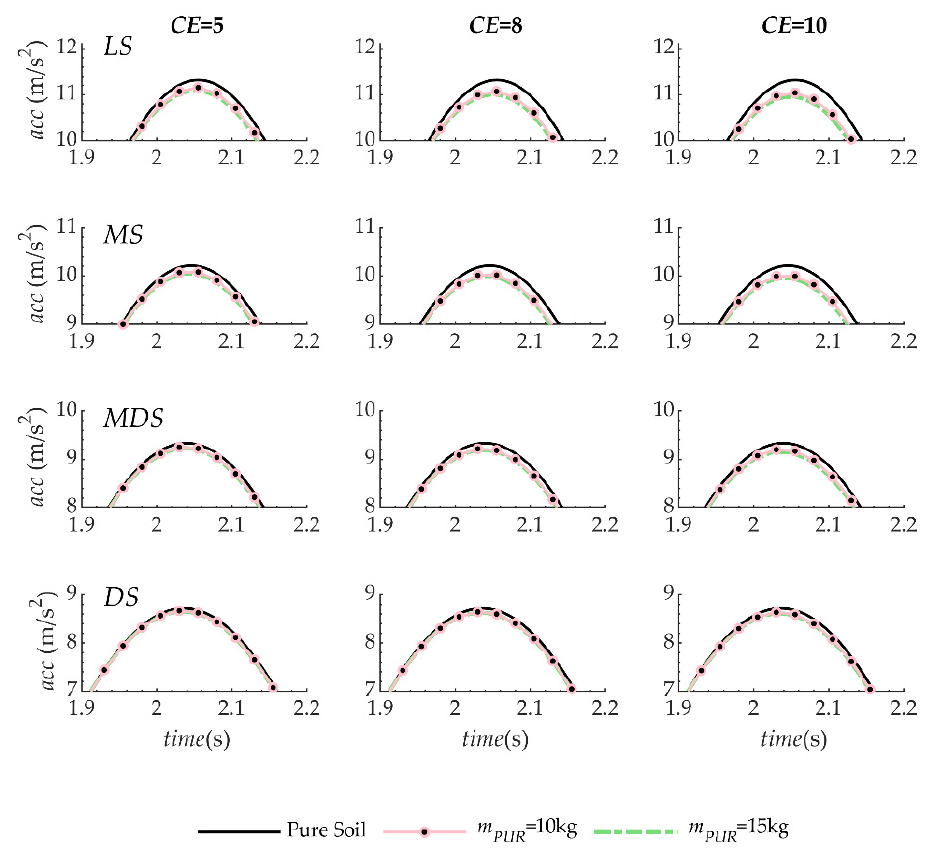
Figure 11. Time-history accelerations recorded on numerical models of pure cohesionless soil at different relative densities and on “modified” cohesionless soil: evidence of the effects of the mass injected per level ( h = 3 m).